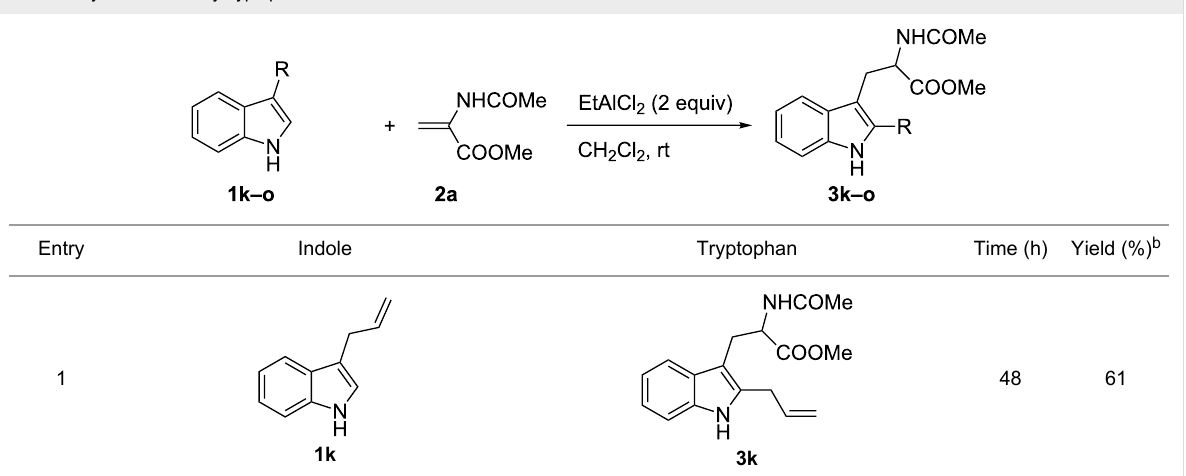
Table 3: Synthesis of 2-allyltryptophans 3k–o .